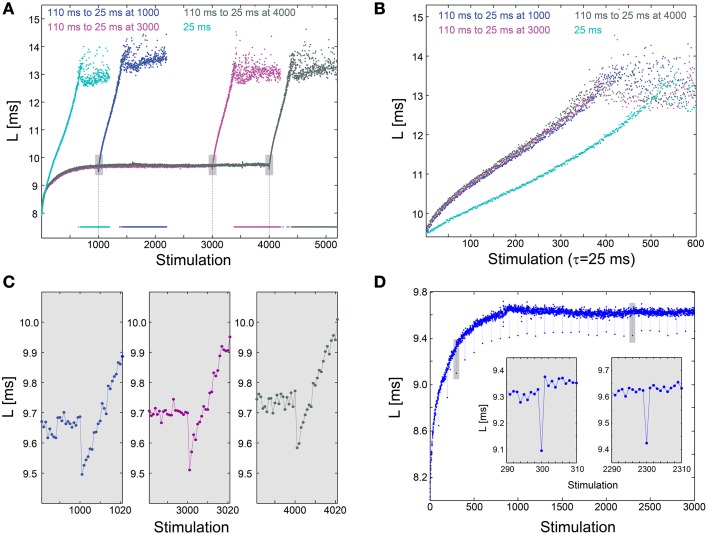
Neuronal plasticity at the stabilized neuronal response latency phase. (A) Stabilization of the neuronal response latency, L, of a cultured neuron at LST ~9.7 ms using τ = 110 ms time-lags between stimulations, followed by an abrupt change to τ = 25 ms, from stimulation 1000 (blue), 3000 (purple), or 4000 (dark gray). Response failures are denoted at L = 7.5 ms. For comparison, L for a periodic stimulation with τ = 25 ms is shown (cyan). (B) Segments of the neuronal response latency profiles following the abrupt change to τ = 25 ms (shown in A), and the profile for L>LST ~9.7 ms for periodic stimulation with τ = 25 ms. (C) A zoom-in of the transitions from τ = 110 to 25 ms (shown by gray boxes in A). (D) The same neuron as in (A), where τ is shortened from 110 ms to 25 ms once every 100 stimulations. Two zoom-ins (gray boxes), indicate momentary facilitation with an amplitude ~0.2 ms.